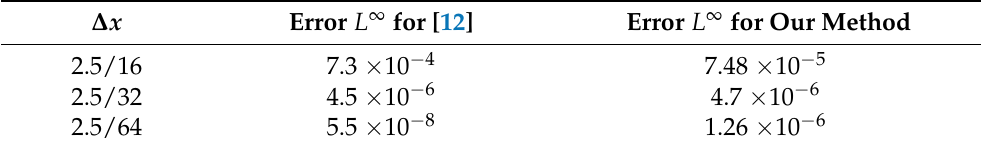
Table 2. Numerical results for parasitic oscillations at non-dimensional time t ∗ = 250 for [12] and our